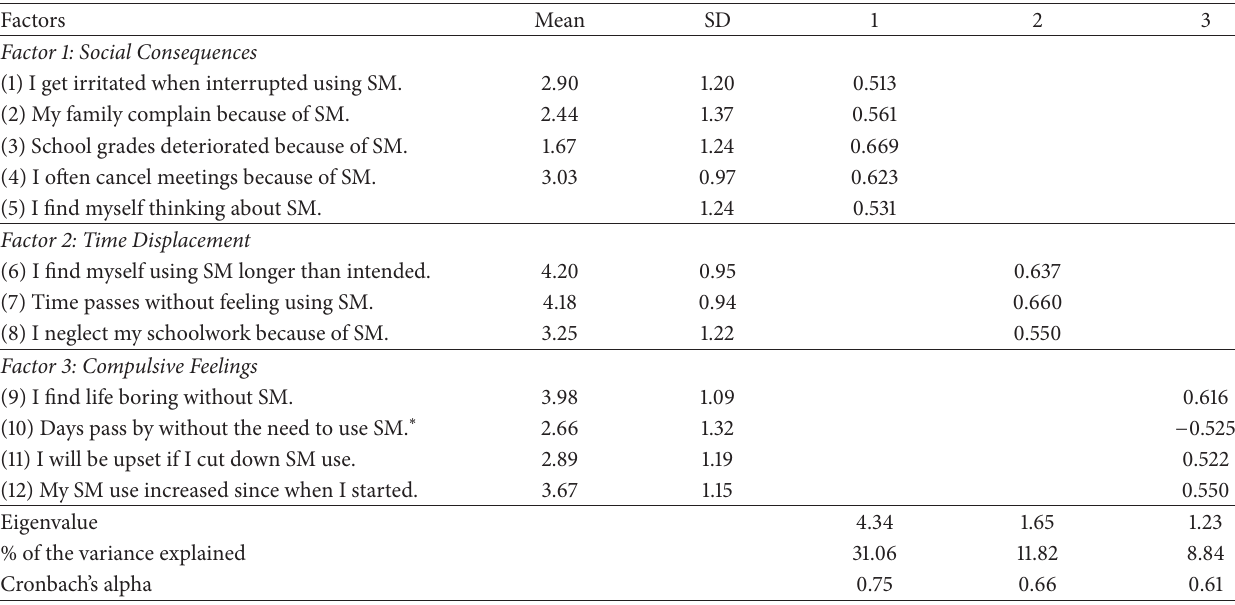
Table 3: Exploratory factor analysis of Social Media Addiction Scale (SMAS).